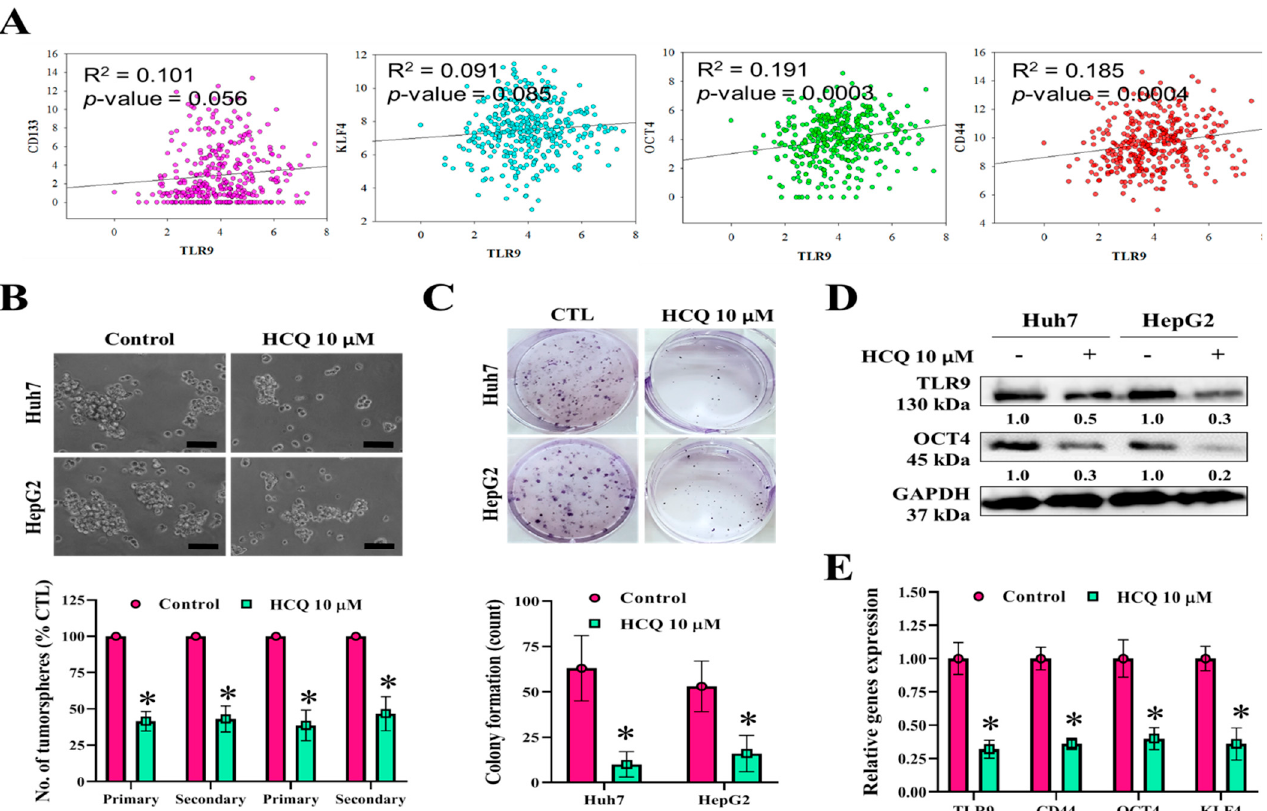
Figure 3. HCQ inhibited HCC cancer stem-like cells’ self-renewal properties. ( A ) Correlation analysis of TLR9 expression with stem cell marker expression. ( B ) HCQ inhibited the tumor sphere-forming capacity (scale bar 200 μ m) and ( C ) colony-forming capacity in HCC (Huh7 and HepG2) cells. The bar plot represents the quantification of tumorsphere and colony-forming abilities after HCQ treatment calculated by ImageJ, provided in (B) (below) and (C) (below), respectively. ( D ) Western blot analysis expression of TLR9 and cancer stem/self-renewal-related marker (Oct4) or GAPDH (loading control). Representative protein bands are shown a reduction in expression TLR9 and Oct4 observed after the HCQ treatment (10 μ M). ( E ) mRNA expression of TLR9, CD44, Oct44, and KLF4 was measured by qRT-PCR; GAPDH was used to normalize the expression levels. Data are the mean ± SEM of three independent experiments. * p < 0.05.